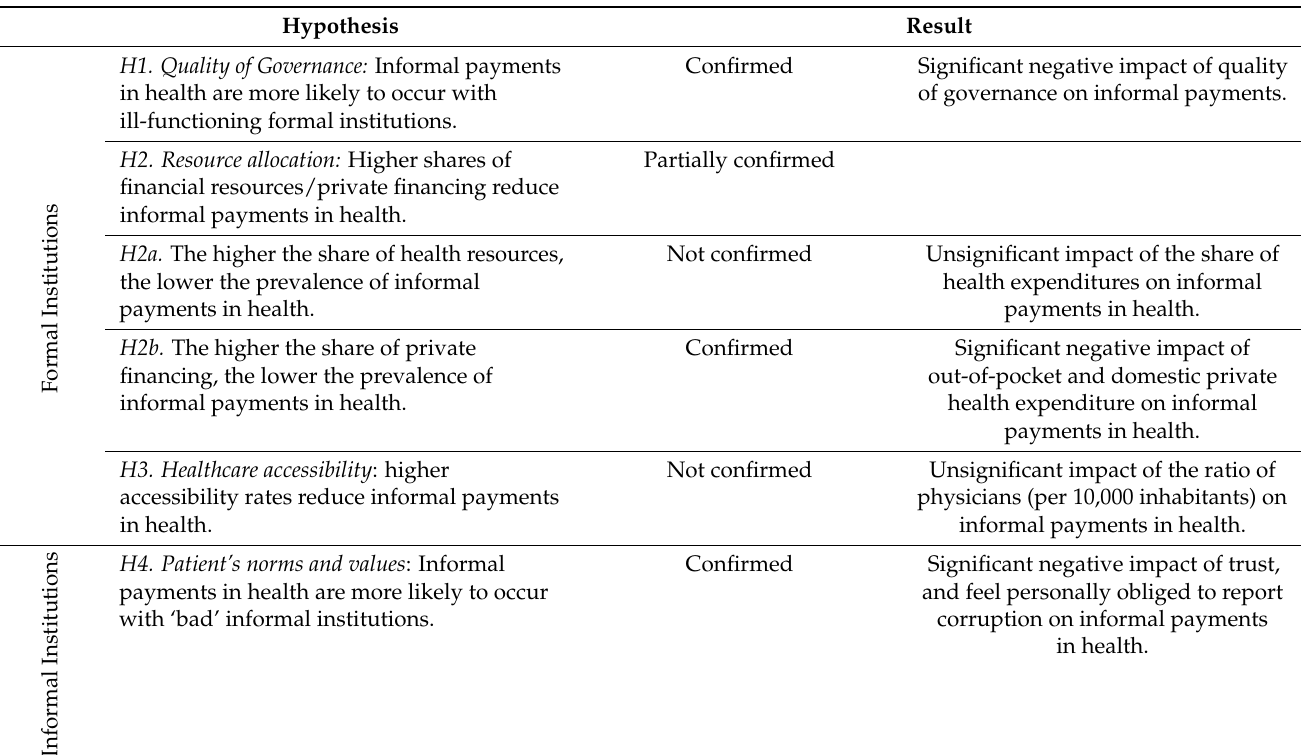
Table 3. Summary of